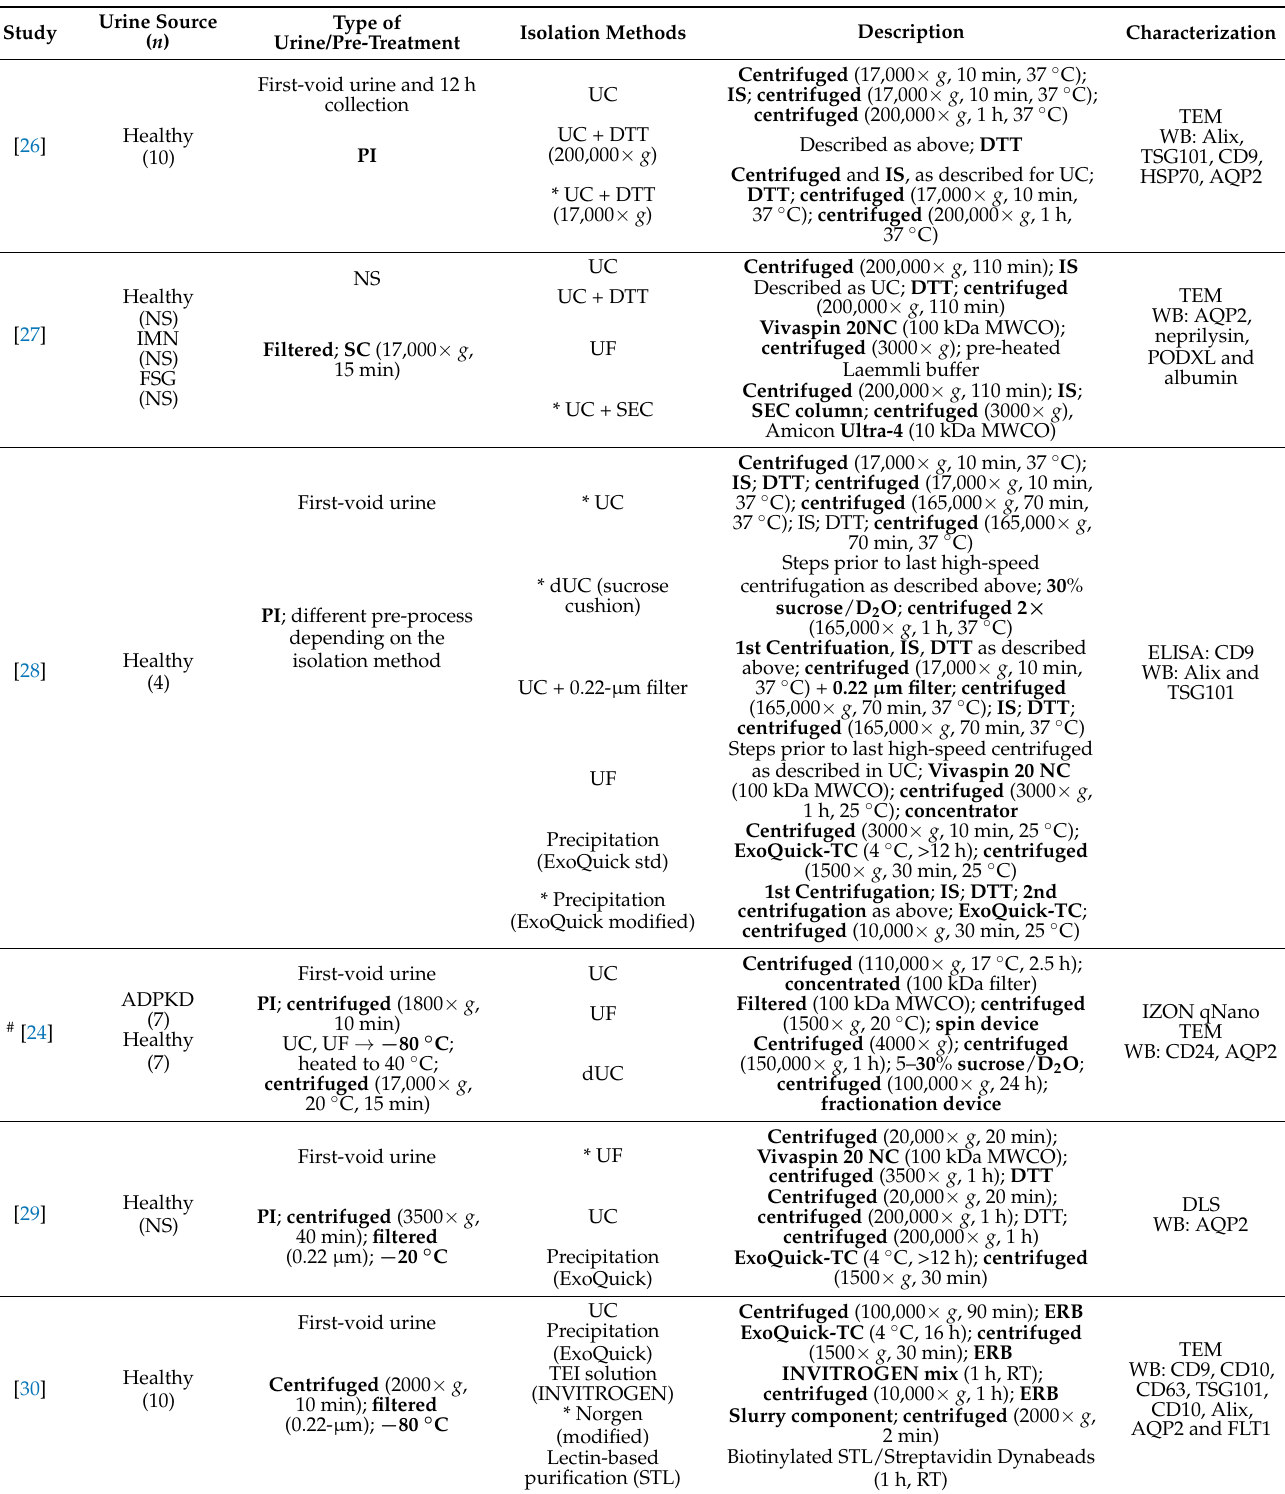
Table 1. Studies comparing different urinary extracellular vesicles (uEV) isolation